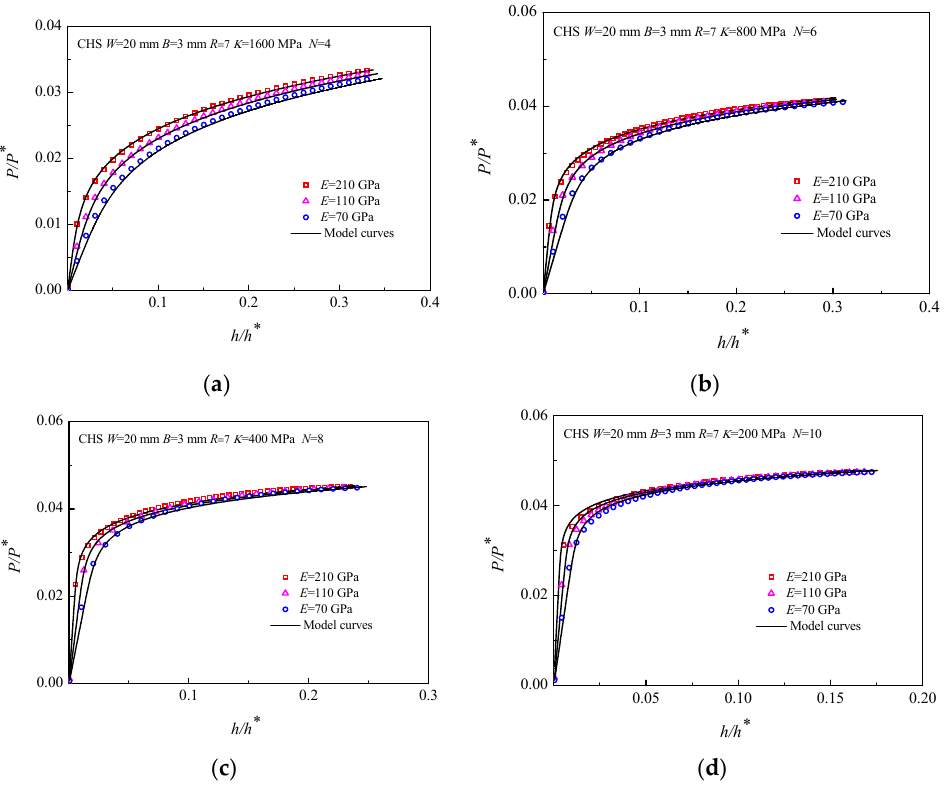
Figure 8. P/P* ~ h/h * curves of the CHS specimens with different elastic moduli E, ( a ) K = 1600 MPa N = 4; ( b ) K = 800 MPa N = 6; ( c ) K = 400 MPa N = 8; ( d ) K = 200 MPa N = 10 . In summary, all three constitutive parameters ( K , N , E ) have impacts on the CHS-LD model, in which N has the clearest effect, whereas the effect of K and E is mainly on the elastic stage of the P/P*~h/h * curves. Furthermore, the above experiments all show that the P/P*~h/h* curves predicted by the CHS-LD model correspond well with the simulated re- sults of different materials. This proves that the CHS-LD model is stabilized and universal. 3.4. Verification of the CHS-SS Model When the P-h curves of CHS specimens and the model parameters of the CHS-SS model are known, the analytical characterization of material constitutive parameters K , N , and E can be completed, and it is possible to fully determine the large-range stress-strain relations of elastic-plastic materials. The related stress-strain curves of materials are de- termined using the P/P *~ h/h * curves in Figure 6. Comparing these stress-strain relations with the initial stress-strain relations input into the finite element software, as shown in Figure 9, two types of stress-strain curves are all in good correspondence with each other. Therefore, the sufficient accuracy and application of the CHS-SS model have been proved. ( a )